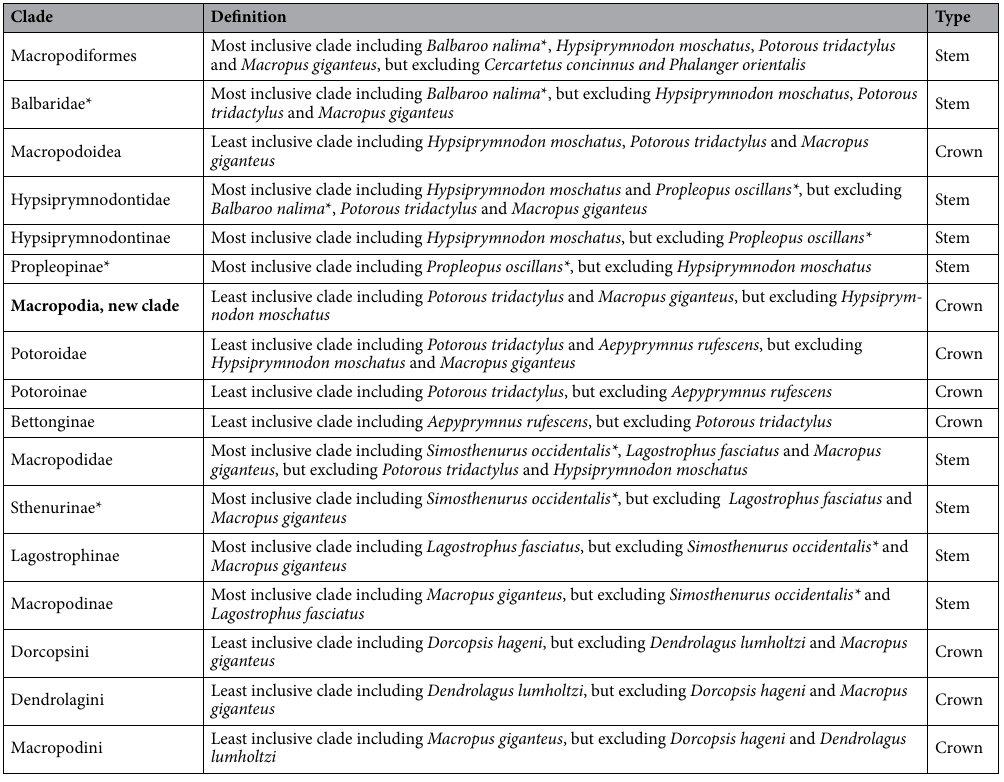
Table 1. Phylogenetic definitions for Macropodiformes, including Macropodia, new clade, and other selected constituent subclades. Conceptual explanations and phylogenetic definition registration details are provided in the Supplementary Information.